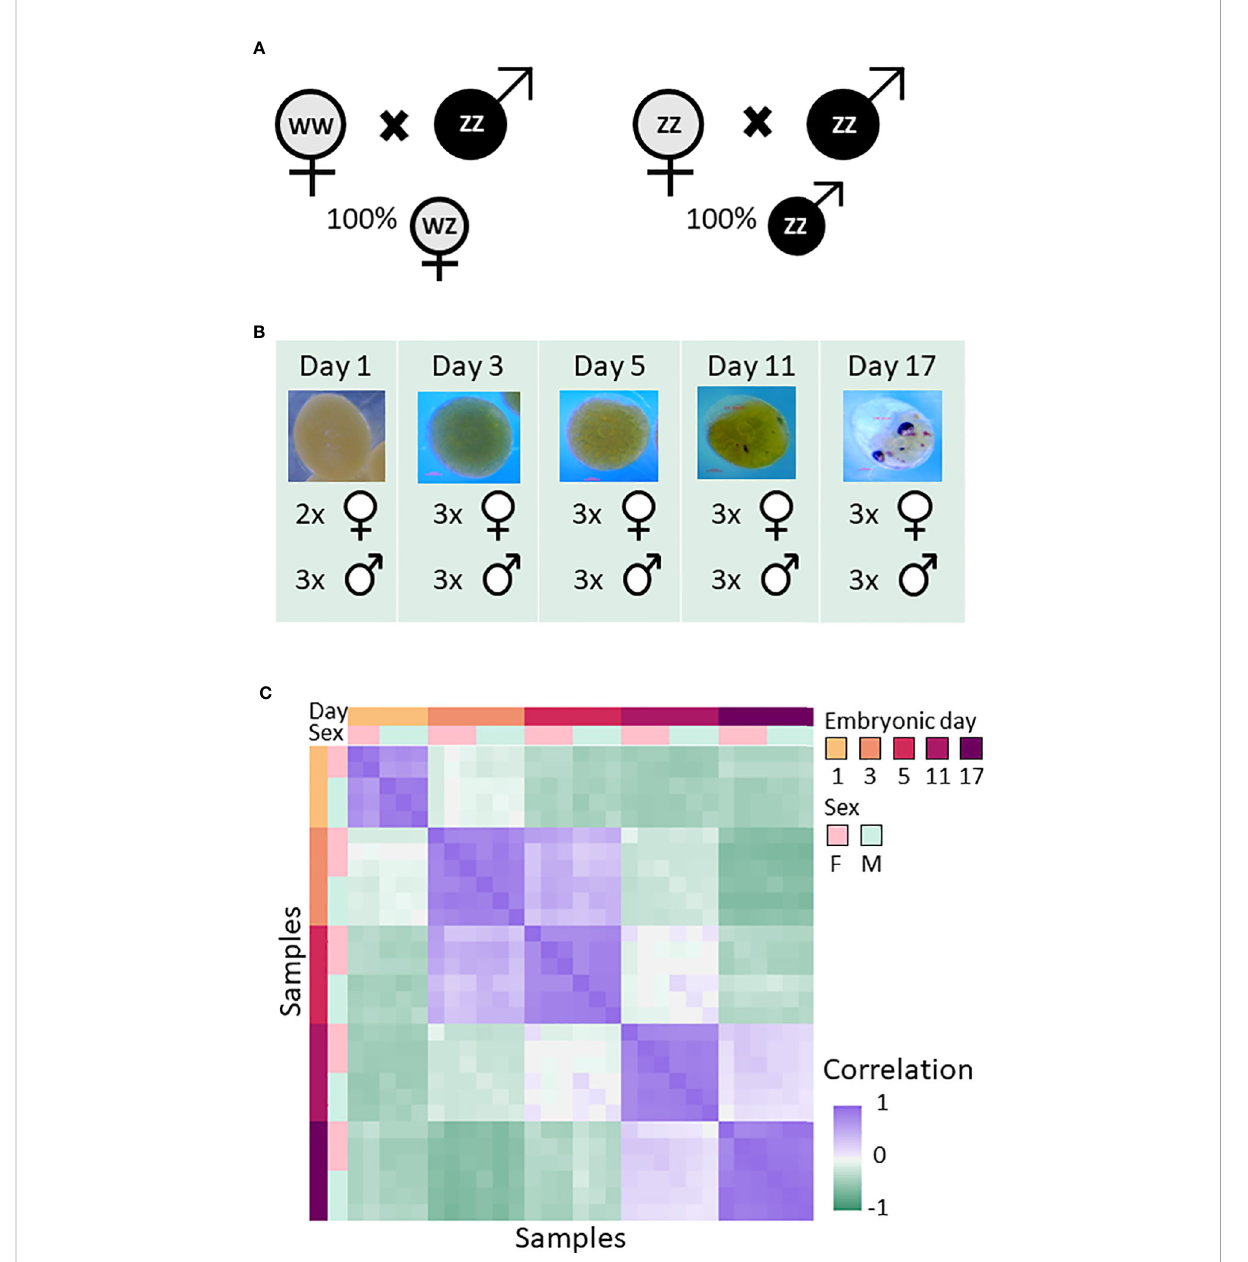
FIGURE 1 Overall experimental design and resemblance between RNA-seq samples of M. rosenbergii embryos sampled on days 1, 3, 5, 11, and 17. (A) Creation of same sex progeny. All-female progeny was obtained by crossbreeding a WW female with a ZZ male (left). All-male progeny was obtained by crossbreeding a ZZ neo-female with a ZZ male (right). (B) Embryos from different egg-bearing females were collected on days 1, 3, 5, 11, and 17 during embryonic development and pooled. On the fi gure, the number of pools from each same-sex progeny on each of the fi ve sampling days is indicated next to the sex symbol. (C) Correlation matrix between the samples, based on the 2,000 most variable genes across all samples. Samples were sorted by embryonic day and sex. Colors represent Pearson ’ s correlation coef fi cient value; see bar on the right of the fi